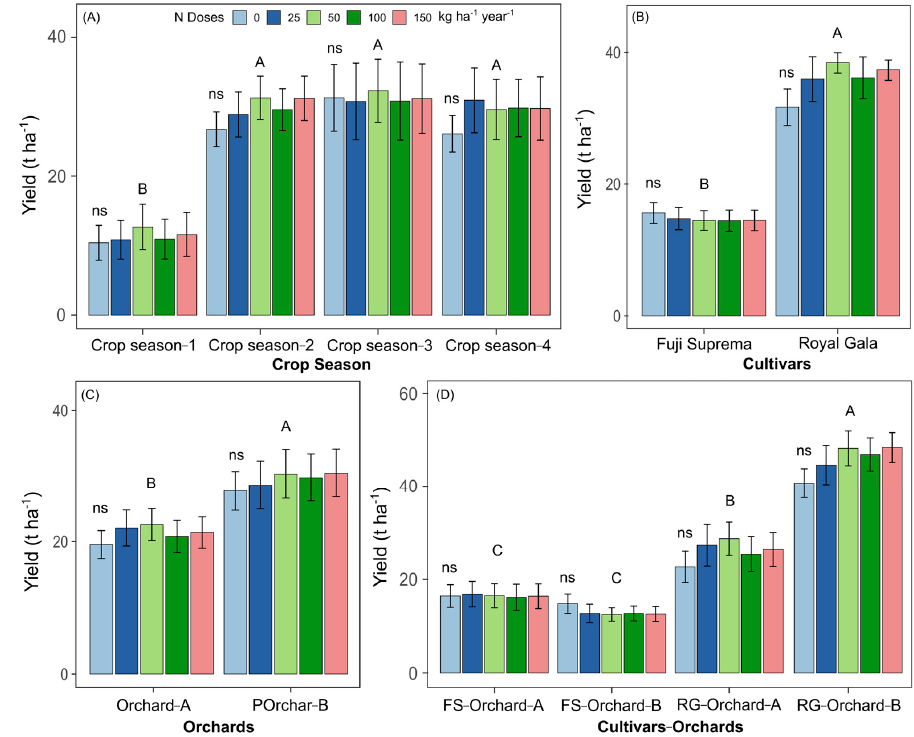
Figure 5. Yield of apple trees subjected to different N rates and its relationship to the “crop season” ( A ), “cultivar” ( B ), “orchard” ( C ) and the “cultivar ∗ orchard” interaction ( D ). Uppercase letters compare the effects of N application rate for each factor (crop season, cultivar, orchard and cultivar—orchard) using Tukey’s test. Differences were considered significant when p value < 0.05; ns: non-significant at p ≥